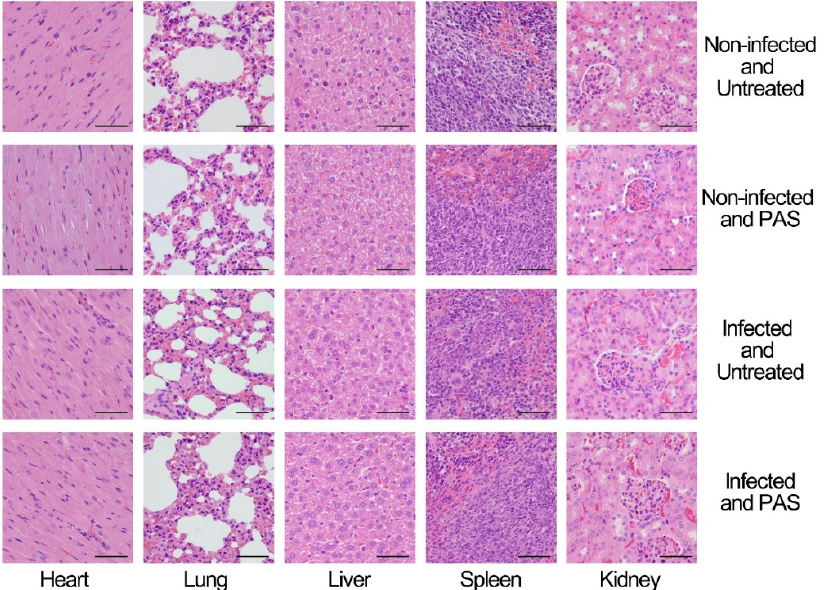
Figure 4. Histopathological analysis of the hearts, lungs, livers, spleens, and kidneys of the mice. The tissues were fixed with paraformaldehyde solution and compared after hematoxylin and eosin (H&E) staining. The bar represents 50 μ m.